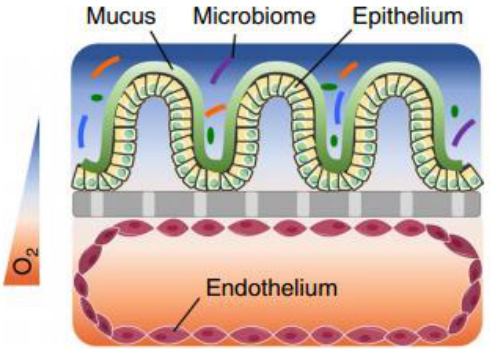
Figure 14. Representation of the microfluidic intestine-chip with microbiome, under the presence of an oxygen gradient (color scale). The human intestinal epithelium is overlaid with its own mucus layer and complex gut biota and positioned over an extracellular matrix-coated porous membrane (grey). The vascular endothelium is situated below the porous membrane. Adopted with permission from [231], Springer Nature, 2019.